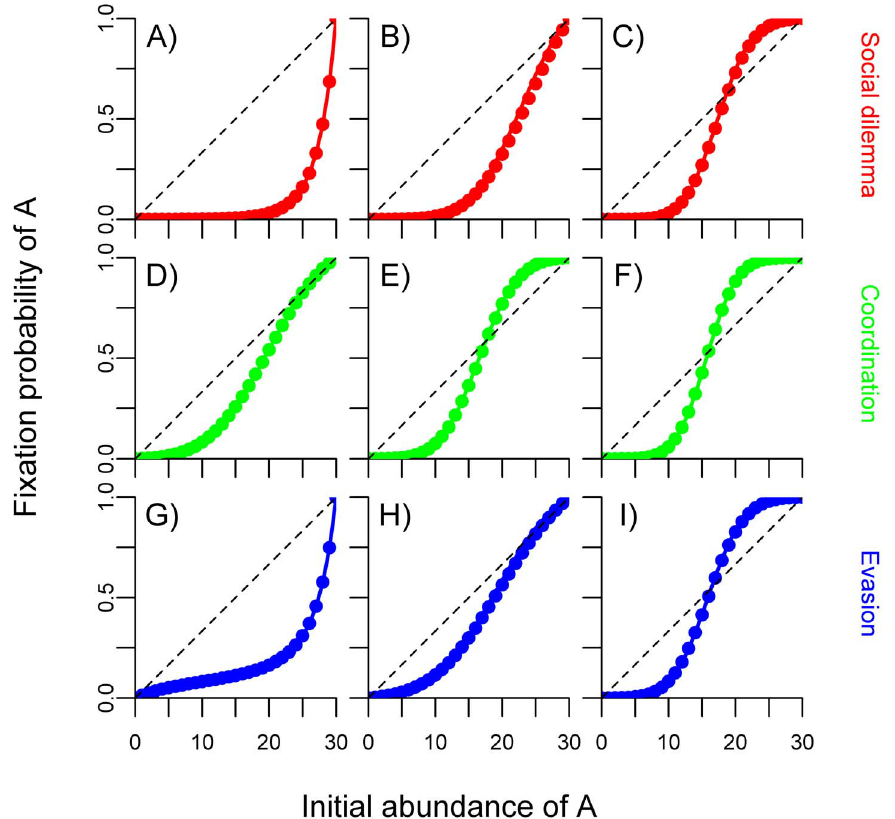
Figure 2. Effects of conformism on the outcome of cultural evolution in a small group. Each panel shows the fixation probability of strategy A as a function of its initial abundance ( k ) in a group of n =30 individuals. Columns of panels correspond to three different frequencies c of conformism. Symbols represent fixation probabilities from the exact stochastic model, and lines represent a diffusion approximation to these fixation probabilities (see File S1, section 2). The diagonal dashed lines indicate the fixation probability of a strategy under random drift ( Q k = k / n ). Parameter settings: b P =1 and b C =2; payoff matrices of the games as in Figure 1.